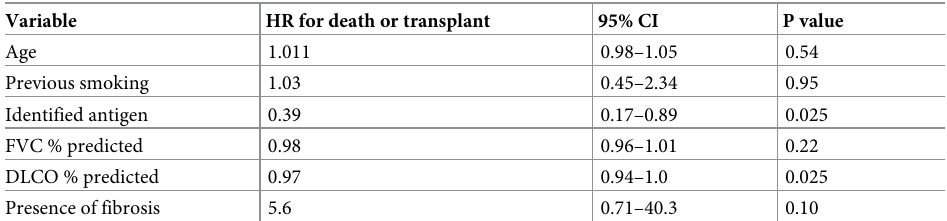
Table 2. Variables included in the Cox proportional hazards survival